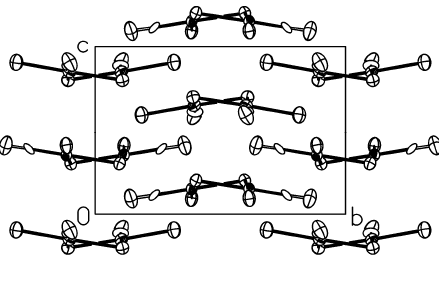
Figure 4. The crystal structure of trans -Pt (bottom) and in the a (top) directions. Some symmetry operators are